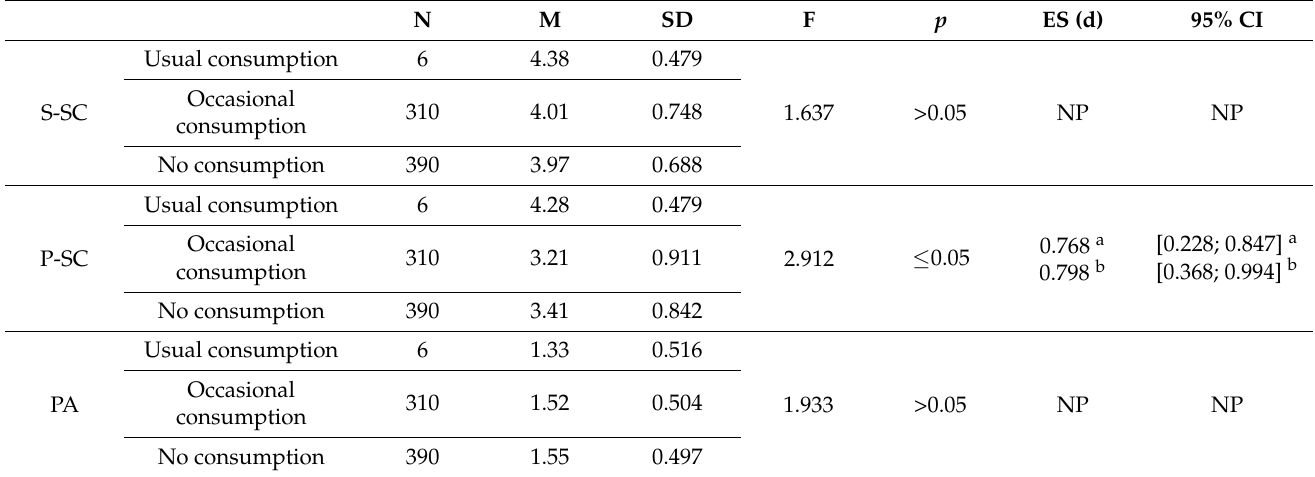
Table 1. Comparative analysis of alcohol consumption.